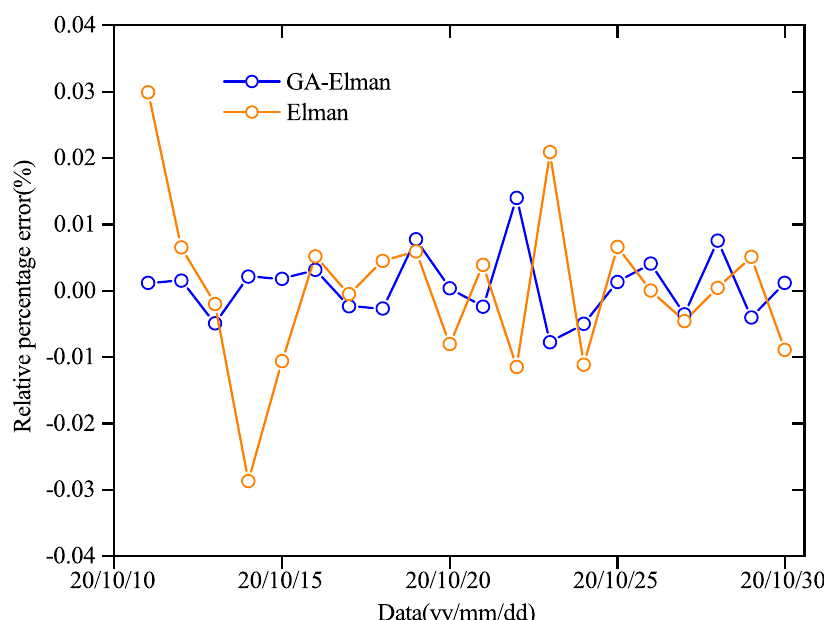
Figure 9. Relative percentage error of prediction with GA-Elman and Elman